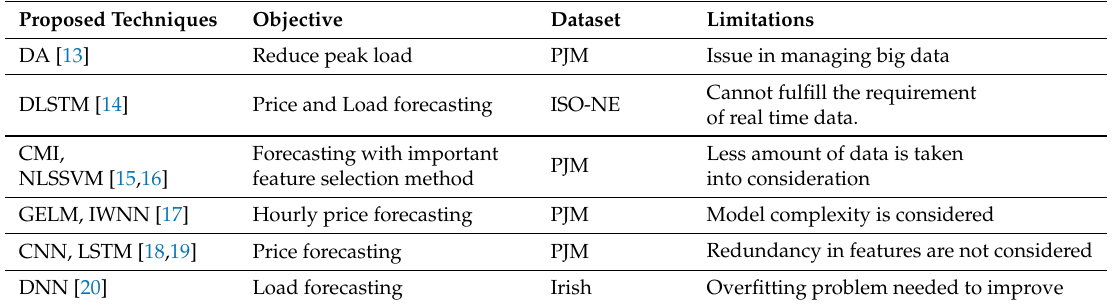
Table 1. Tabular form of related